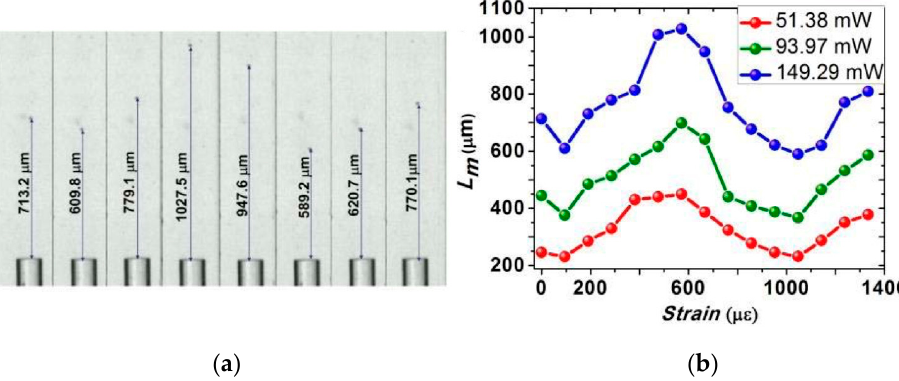
Figure 8. ( a ) Microscopic images of strain controllable optical manipulation by increasing the strain to 0, 95 με , 286 με , 571 με , 667 με , 1048 με , 1143 με , and 1238 με , respectively. ( b ) Manipulation length versus strain at flow rate of v = 150 nL/min [61] .